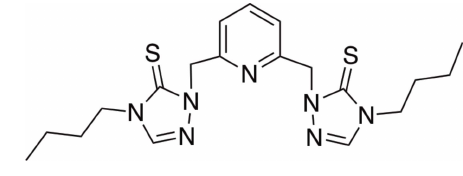
Figure 2 Structure of the ambidentate pincer ligand precursor.